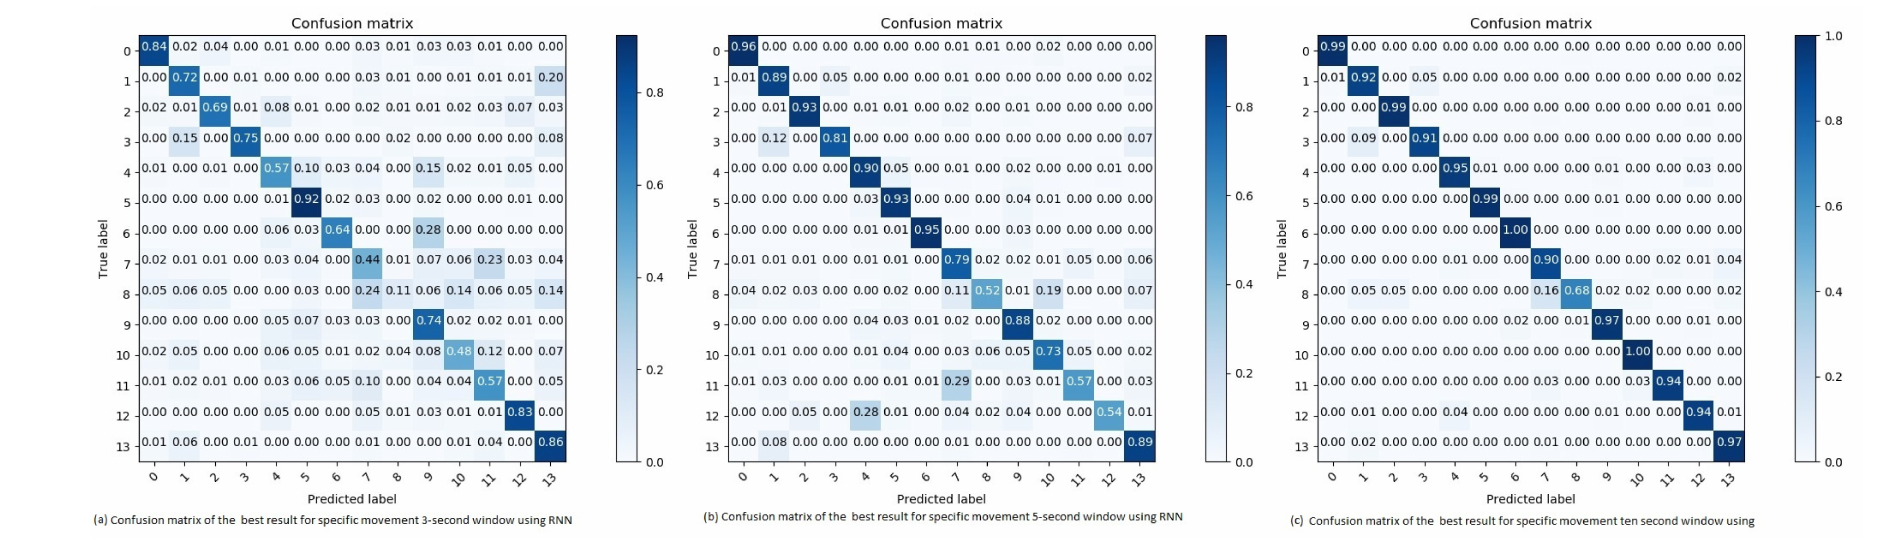
Figure 10. Confusion matrix of the best result for specific movement 3, 5 and 10-s window using